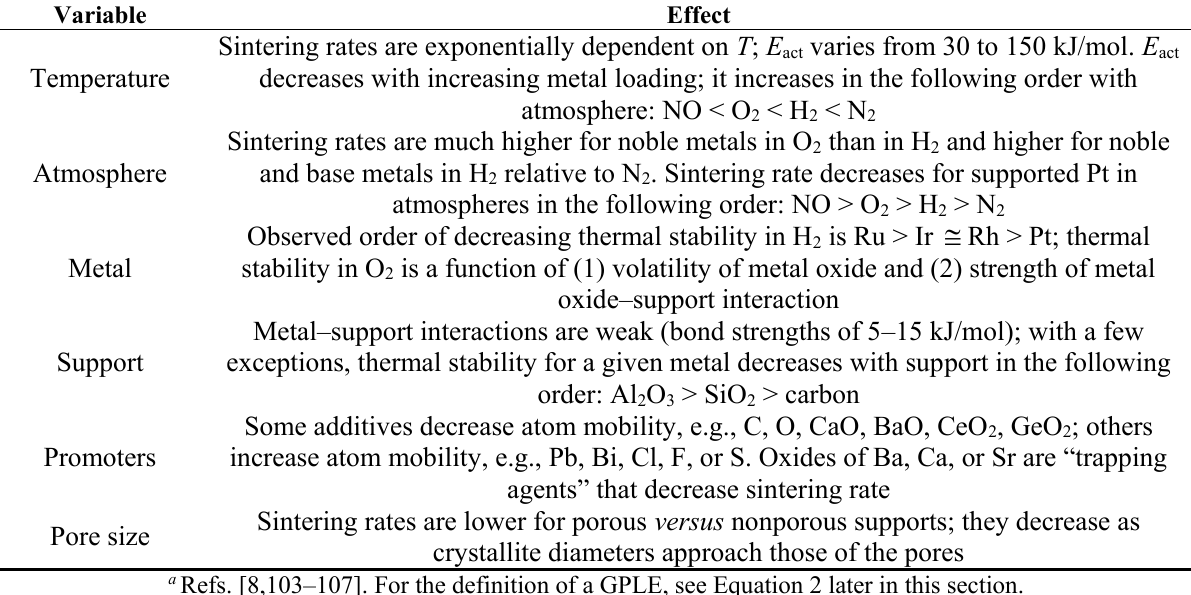
Table 8. Effects of Important Reaction and Catalyst Variables on Sintering Rates of Supported Metals Based on General Power-Law Expression (GPLE) Data a